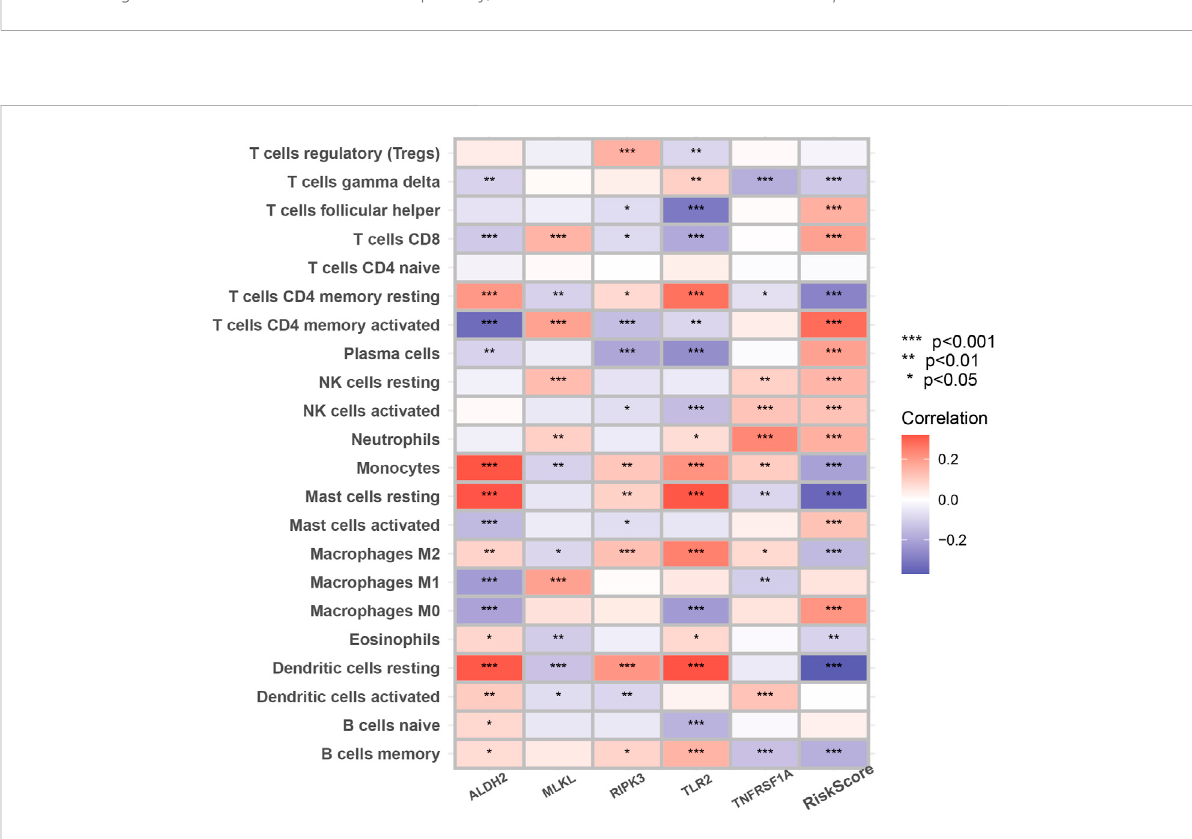
FIGURE 7 The correlation between in fi ltrating immune cells and NRGs in the signature. The change in the color of blocks implies the strength of the correlation (* p < 0.05; ** p < 0.01; *** p <